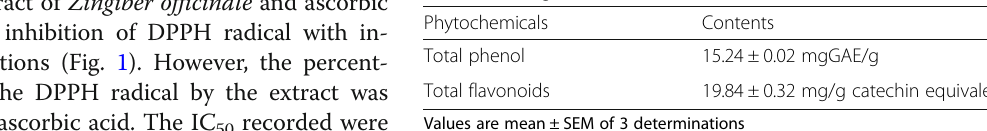
Table 2 Total phenols and flavonoids contents of